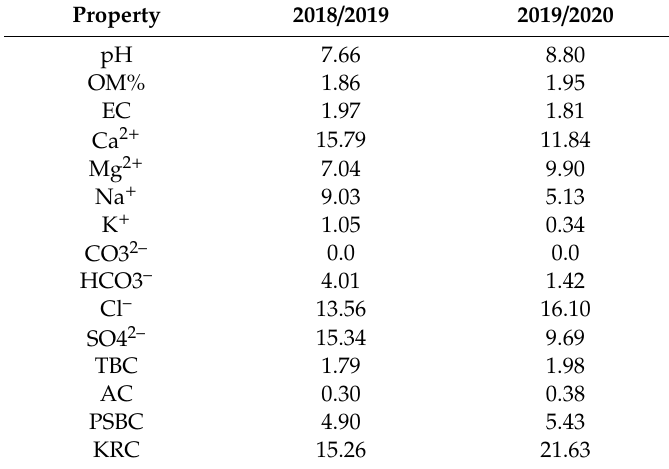
Table 2. Physicochemical and biological properties of soil used in the two growing seasons, 2018 and